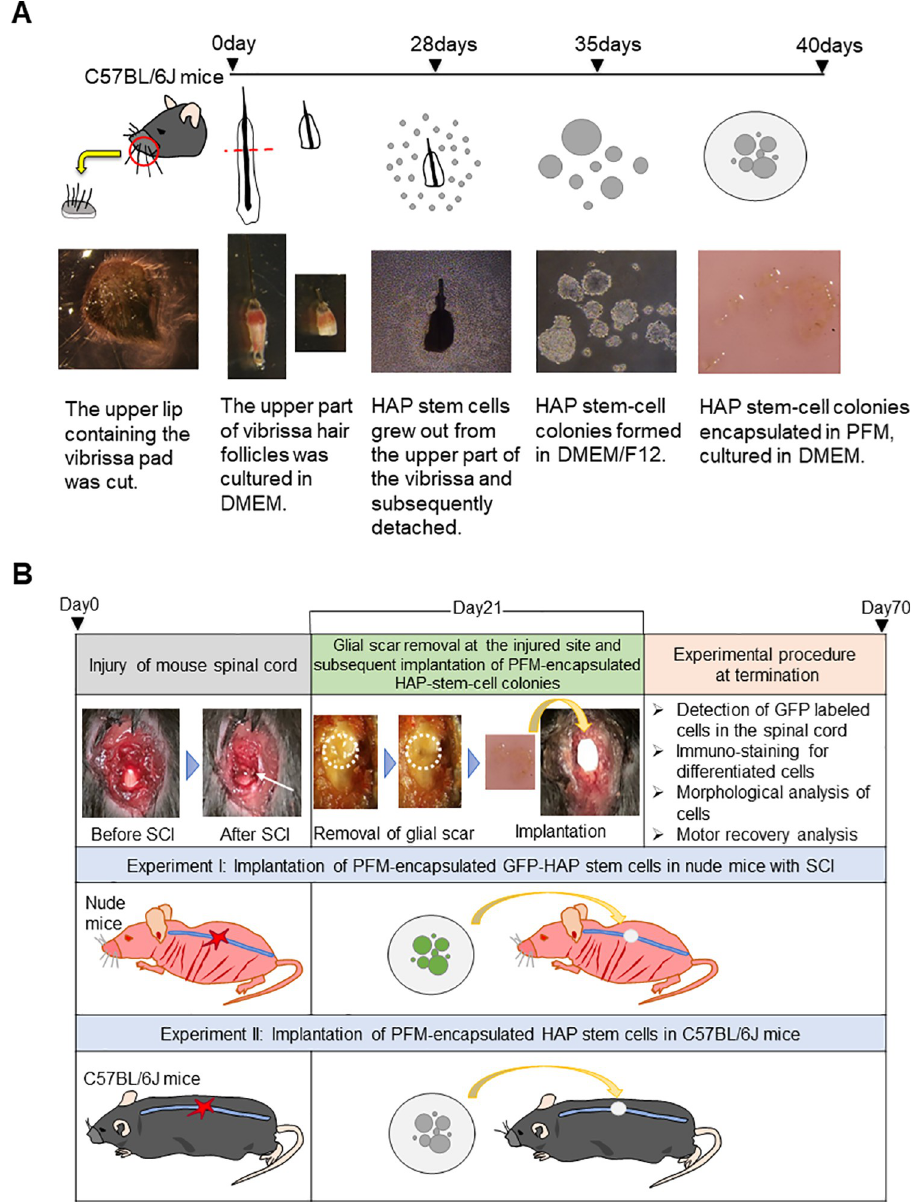
Fig 1. Experimental flow diagram. (A) Procedure for isolation, culture and encapsulation of HAP stem cells. (B) Procedure for implantation of PFM-encapsulated HAP stem cells. Experiment I: GFP-expressing PFM-encapsulated HAP stem cells from C57BL/6J GFP mice were implanted in the severed thoracic spinal cord of nude mice with SCI three week after injury. Experiment II: PFM-encapsulated HAP stem cells of C57BL/6J mice without GFP expression were implanted in C57BL/6J mice with